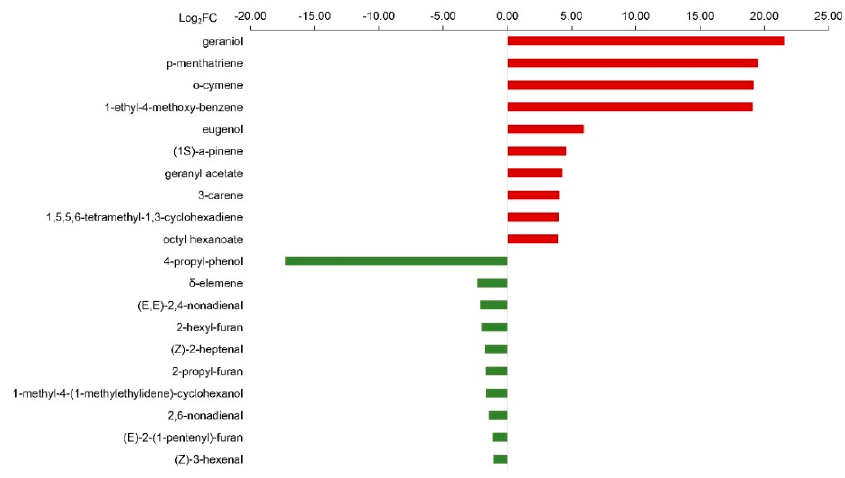
Figure 3. Top 20 differential metabolites in TH vs. TL blooming flowers. Red rows are metabolites accumulated up-regulated in TH, and green rows are metabolites increased more in TL.